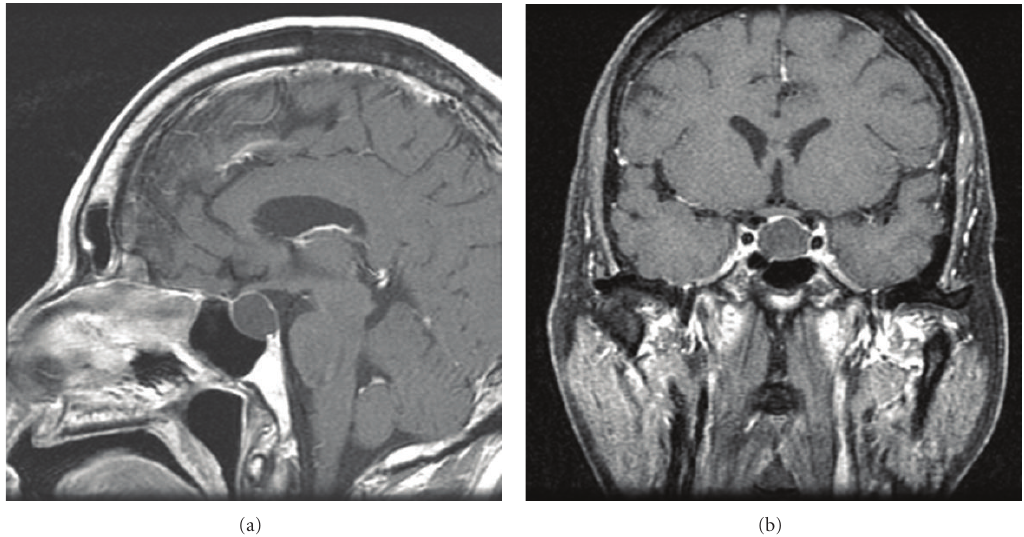
Figure 3: Sagittal and coronal postcontract MRI in late June revealing a sellar-suprasellar mass with some optic compression. Clinicians are cautioned to be aware of this phenomenon when evaluating a patient with an empty sella. Treatment resulted in a radiographic remission of the Rathke’s cyst, and relief of optic compression and visual loss, but failed to reverse the hypopituitary status as of a 12-month